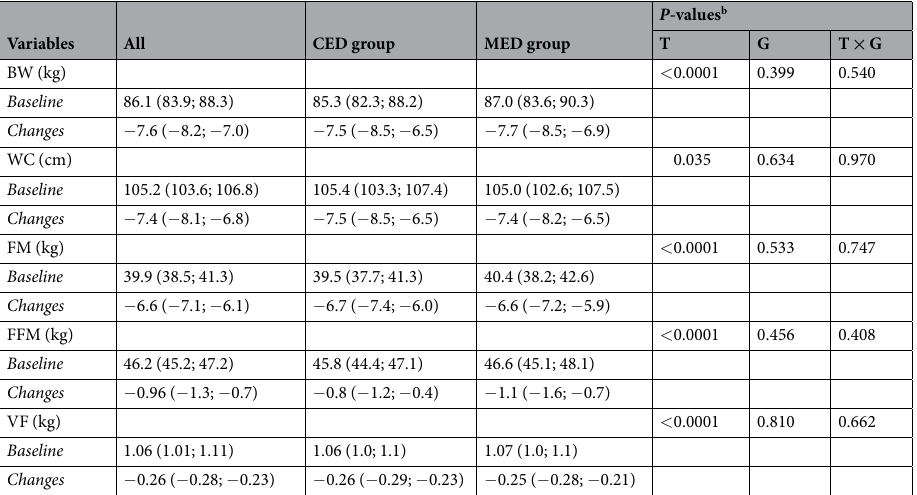
Table 1. Subject characteristics before and changes in anthropometric parameters after the dietary intervention, analyzed with ITT a . Abbreviations: BW: body weight; WC: waist circumference; FM: fat mass; FFM: fat-free mass; VF: visceral fat; T: time; G: group; T × G: time–group interaction; a Values are expressed as means (95% CI); b Linear mixed model for values at each time point, significant at P < 0.05; CED: baseline: n = 72; week 4: n = 70; week 8: 68; week 12: n = 65; week 16: n = 63; MED: baseline: n = 72; week 4: n = 72; week 8: 72; week 12: n = 70; week 16: n = 67; in the table values at baseline and changes from baseline to follow-up are